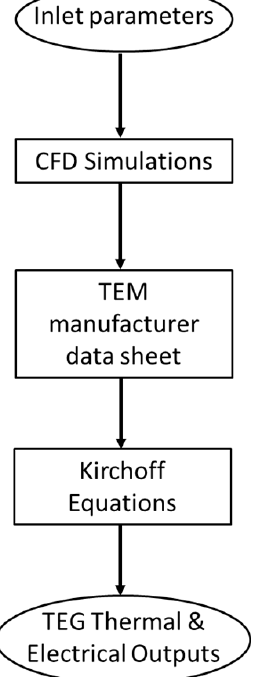
Figure 1. General view of the thermoelectric model block diagram.